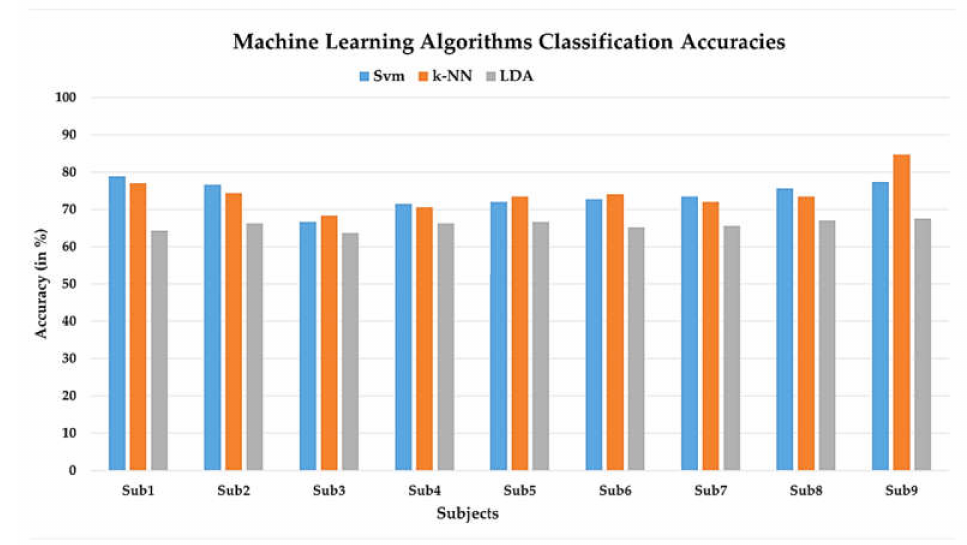
Figure 9. Machine-learning (ML) classifier accuracies (in %) for nine subjects. The ML classifiers are support vector machine (SVM), k-nearest neighbor (k-NN), and linear discriminant analysis (LDA).